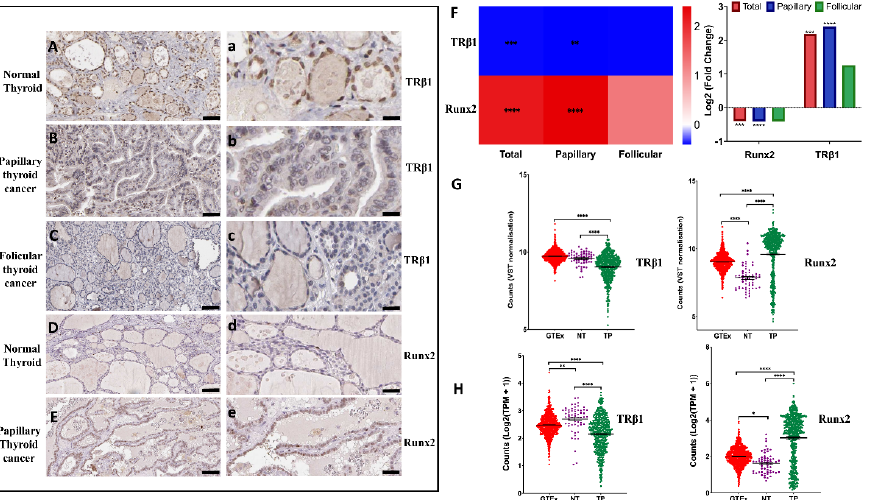
Figure 1. TR β 1 and Runx2 protein expression in human normal and thyroid cancer tissues. ( A , a ), Representative images of normal thyroid tissue; ( B , b ) , Representative images of papillary thyroid cancer tissue; and ( C , c ), Representative images of follicular thyroid cancer tissue stained with TR β 1antibody CAB002009. ( A – C ) , Scale bar 50 µm, 20× magnification, ( a – c ) , scale bar 20 µm, 63× magnification. ( D , d ), Representative images of normal thyroid tissue and ( E , e ), Representative im- ages of papillary thyroid cancer tissue stained with Runx2 antibody CAB068226. ( D , E ), Scale bar 50 µm, 20x magnification, ( d , e ), scale bar 20 µm, 63× magnification. The final images were acquired using case viewer software 2.3 (3DHITECH Ltd., Germany, https://www.3dhistech.com/re- search/software-downloads/, accessed on 12 January 2022). ( F ), Heatmap and bar plot to visualize differential expression of TR β 1 and Runx2 in tumor compared to their matched adjacent tissues in total, papillary and follicular thyroid cancer patients, respectively. The color intensity of heatmap represents log2 Fold Changes. In bar plot, data were presented as log2-transformed fold change calculated by DESeq2 algorithm. Significances have been corrected by the Benjamini–Hochberg method. ( G , H ), TR β 1 and Runx2 expression comparisons among normal controls (GTEx), thyroid para-cancerous tissues (NT) and their matched thyroid cancer tissues (TP). The expression profiles were extracted from the retrieved datasets (TCGA and GTEx) after variance stabilizing transfor- mation (VST) or after converting raw counts to performing transcripts per million (TPM), followed by log2 transformation. Data were presented as mean ± SEM. One-way ANOVA test was used to assess statistical significance. **** p < 0.0001, *** p < 0.001, ** p < 0.01, * p < 0.05 . 3.2. Differential Expression of TR β 1 and Runx2 Genes in Normal Thyroid Tissues vs. Thyroid Cancer Expression levels of TR β 1 and Runx2 genes were compared between thyroid tumor tissues ( n = 502) and normal tumor-adjacent or para-cancerous thyroid tissues ( n = 58) using RNA sequencing data from the TCGA Thyroid Carcinoma cohort. The expression of the TR β 1 gene was significantly down-regulated, while the Runx2 gene was signifi- cantly up-regulated in both the papillary and combined thyroid cancer tissues (Total), compared to respective tumor adjacent normal thyroid tissues (NT) (Figure 1F). Further- more, in a comparison of TR β 1 and Runx2 expression in normal thyroid solid tissues, tu- mor adjacent normal thyroid tissues (NT) and thyroid tumor tissues (TP), we observed that the expression of TR β 1 was downregulated in thyroid tumor tissues (TP) compared to both normal thyroid tissues (GTEX) and tumor adjacent thyroid tissues (NT) (Figure 1G). However, Runx2 expression was upregulated in thyroid tumor tissues (TP) com- pared to both normal thyroid tissues (GTEX) and tumor adjacent thyroid tissues (NT) (Figure 1H).